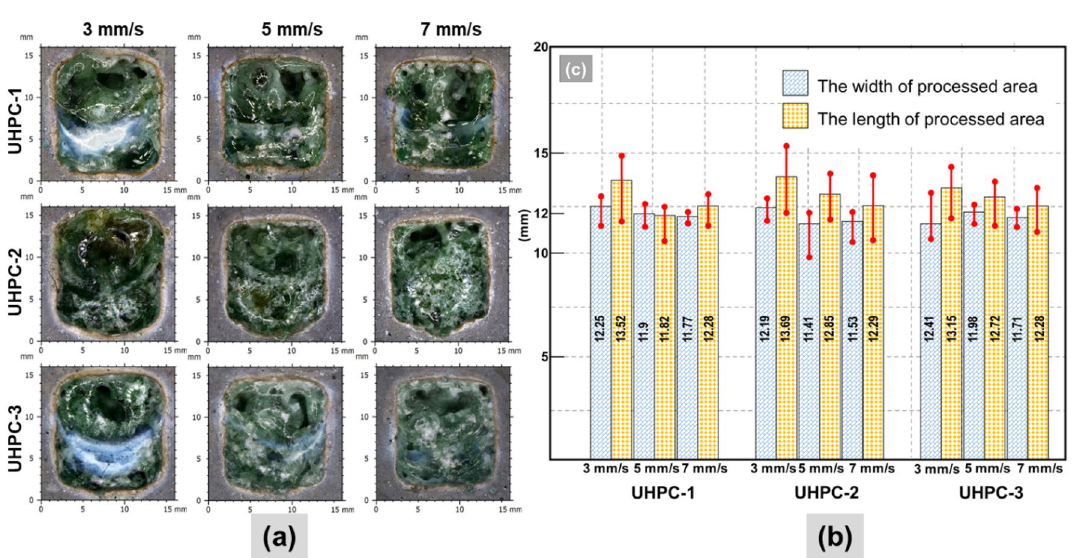
Figure 4. ( a ) Surface observation of UHPC series samples; ( b ) Dimension of UHPC series samples by using the confocal